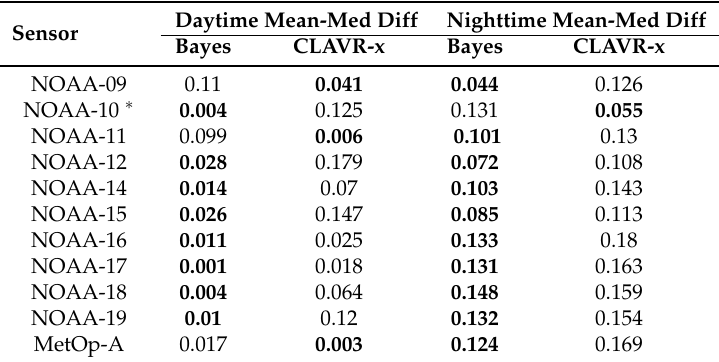
Table 11. Median bias, and absolute difference between mean and median bias for two-channel (10.8 and 12 µ m) daytime and three-channel (3.7, 10.8 and 12 µ m) nighttime SST retrieval statistics using Bayesian and CLAVR-x cloud masks compared against GTMBA data.